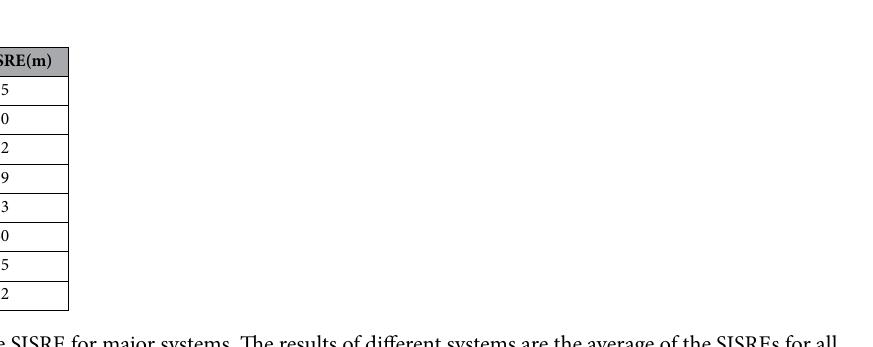
Table 5. Average SISRE for major systems. The results of different systems are the average of the SISREs for all days from Aug 1, 2020 to Sep 1,